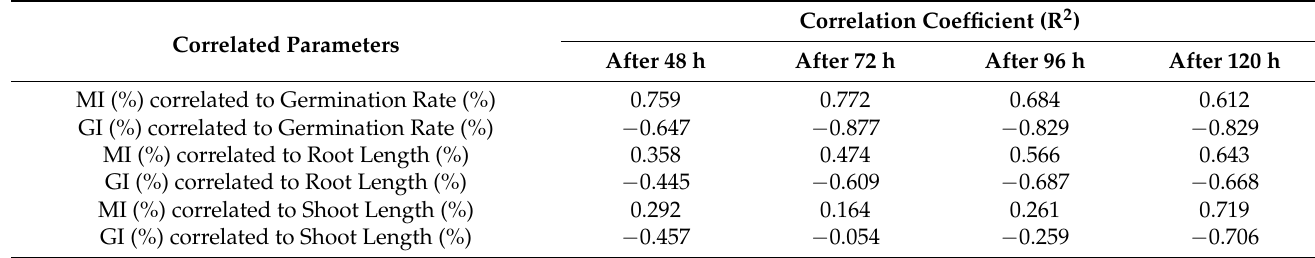
Table 7. Correlations between cytogenetic parameters and biometric parameters in wheat treated with non-thermal plasma-activated